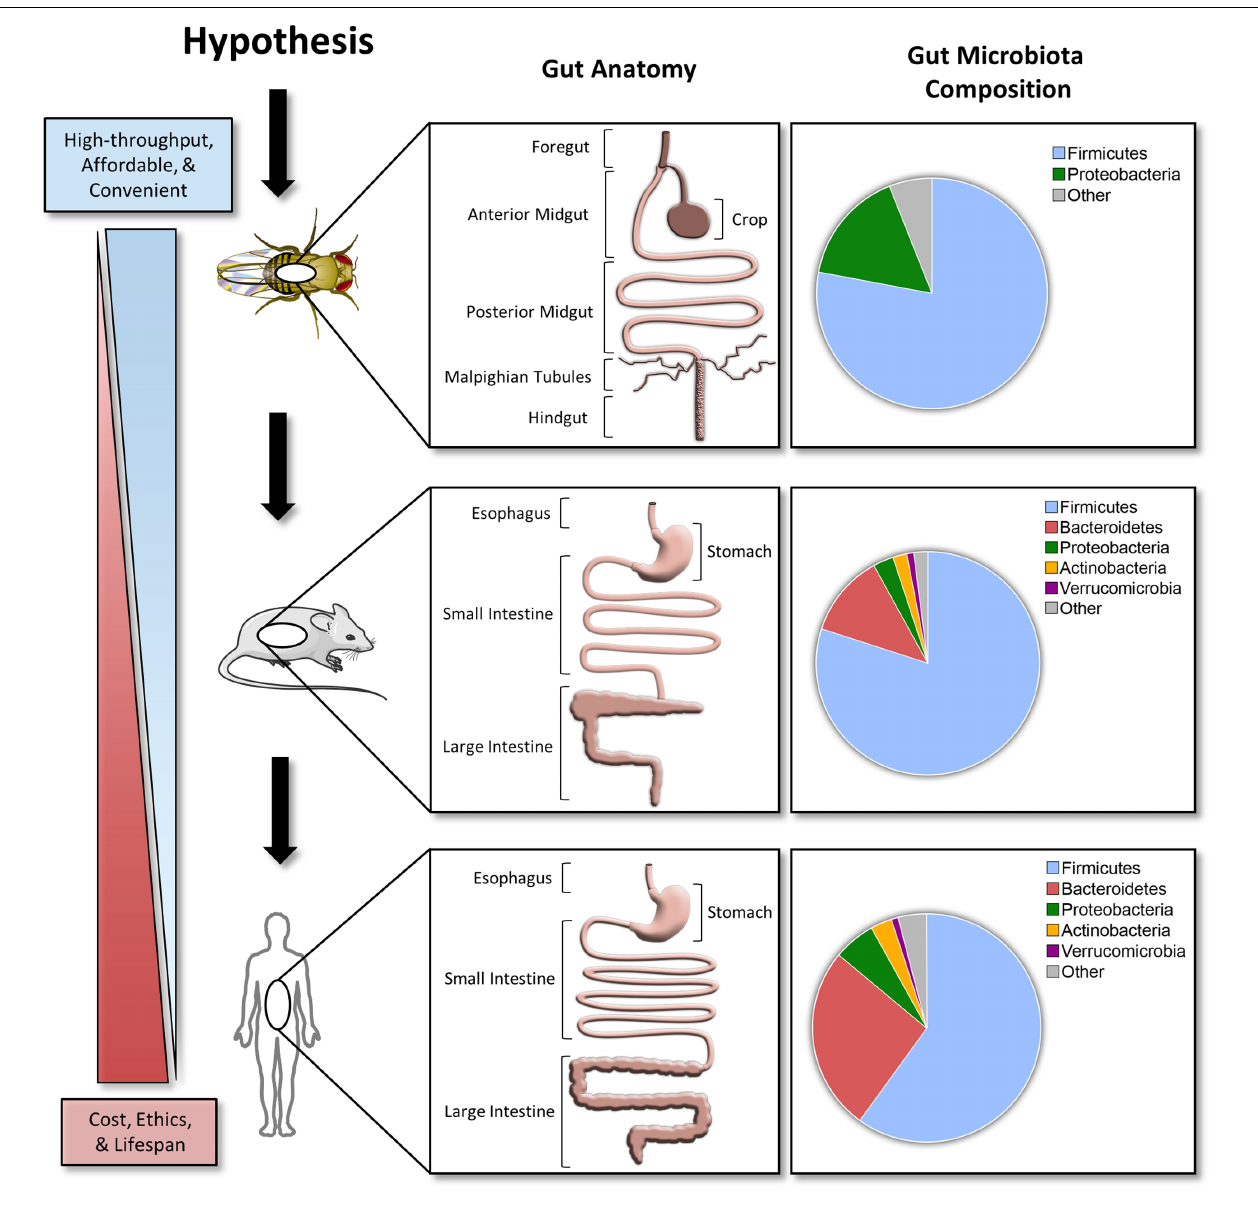
FIGURE 1 | A hypothesized pipeline approach investigating host–microbe interactions. Comparisons between the Drosophila melanogaster , C57BL/6 mice, and human gut anatomy and microbiota. Taxonomical distribution data for top phyla in D. melanogaster are based off 454 tag pyrosequencing (Blum et al., 2013). C57BL/6 mice and human data are based off a 2.6 and 4.6 M catalog, respectively (Xiao et al., 2015). Stock clipart images from Servier Medical Art by Servier were used and modified under the Creative Commons Attribution 3.0 Unported